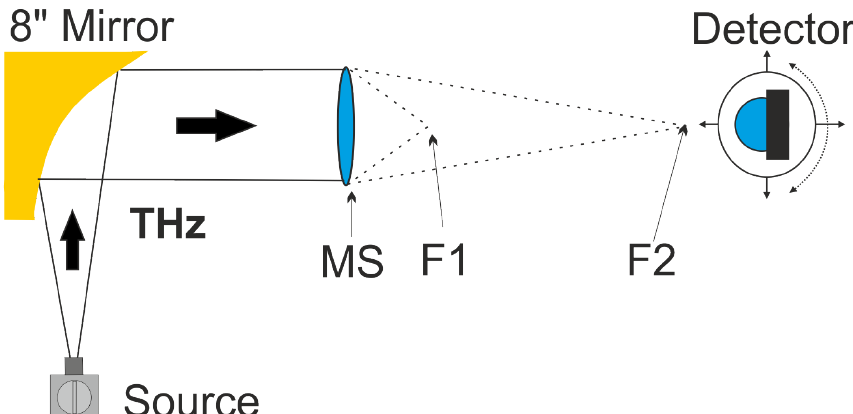
Figure 4. Simplified schematic diagram of the experimental setup. (MS)—Measured Structure, (F1)—100 mm focal point, (F2)—700 mm focal point.